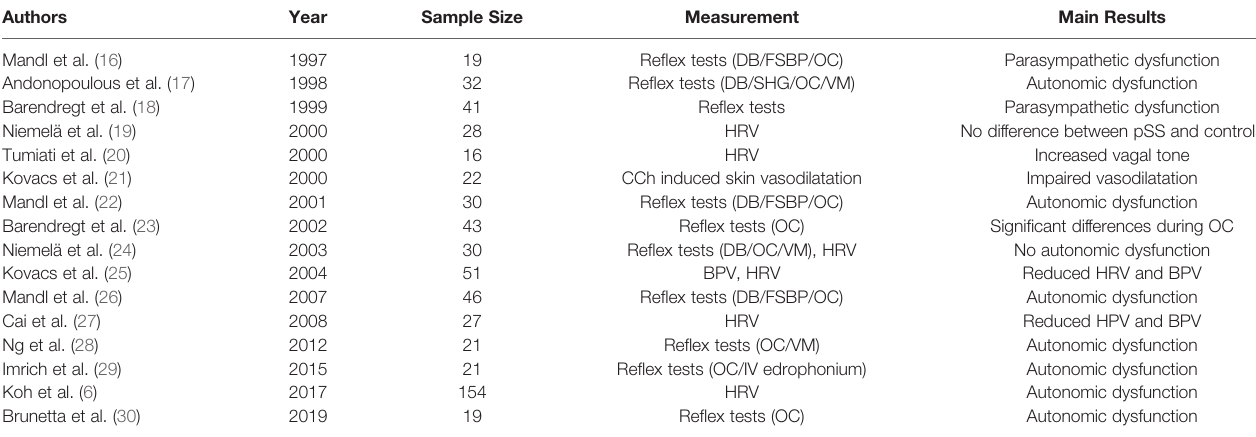
TABLE 1 | A summary of studies investigating ANS function in patients with pSS. Authors Year Mandl et al.